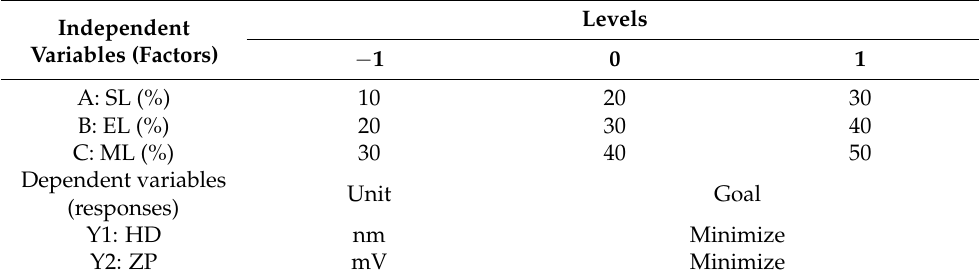
Table 1. Variables in the Box–Behnken design for the formulation development of